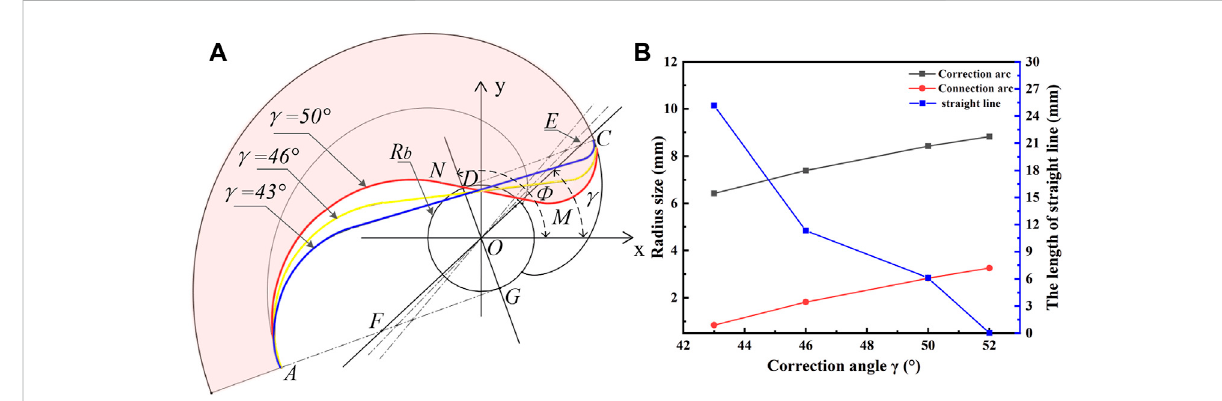
FIGURE 3 (A) EA-SAL correction (B) The relationship between the correction angle γ and the correction arc radius and the correction straight line length.